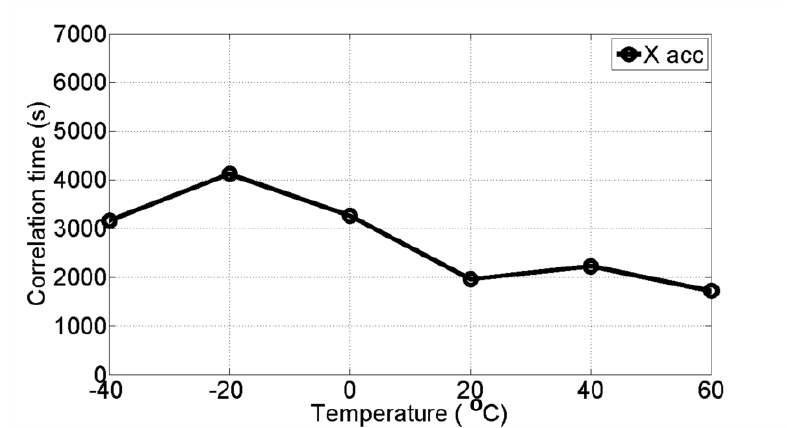
Figure 9. Correlation times for the three accelerometers (X acc, Y acc, and Z acc) at different temperature